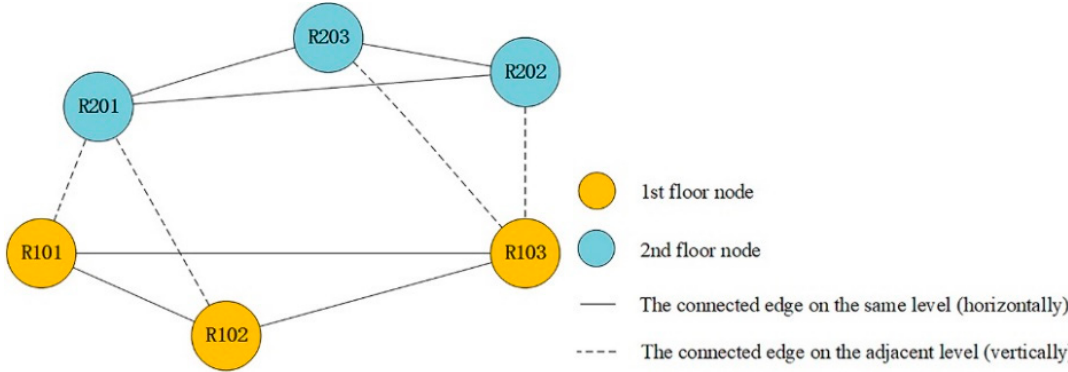
Figure 13. Diagram of adjacent relations for cellular spaces.